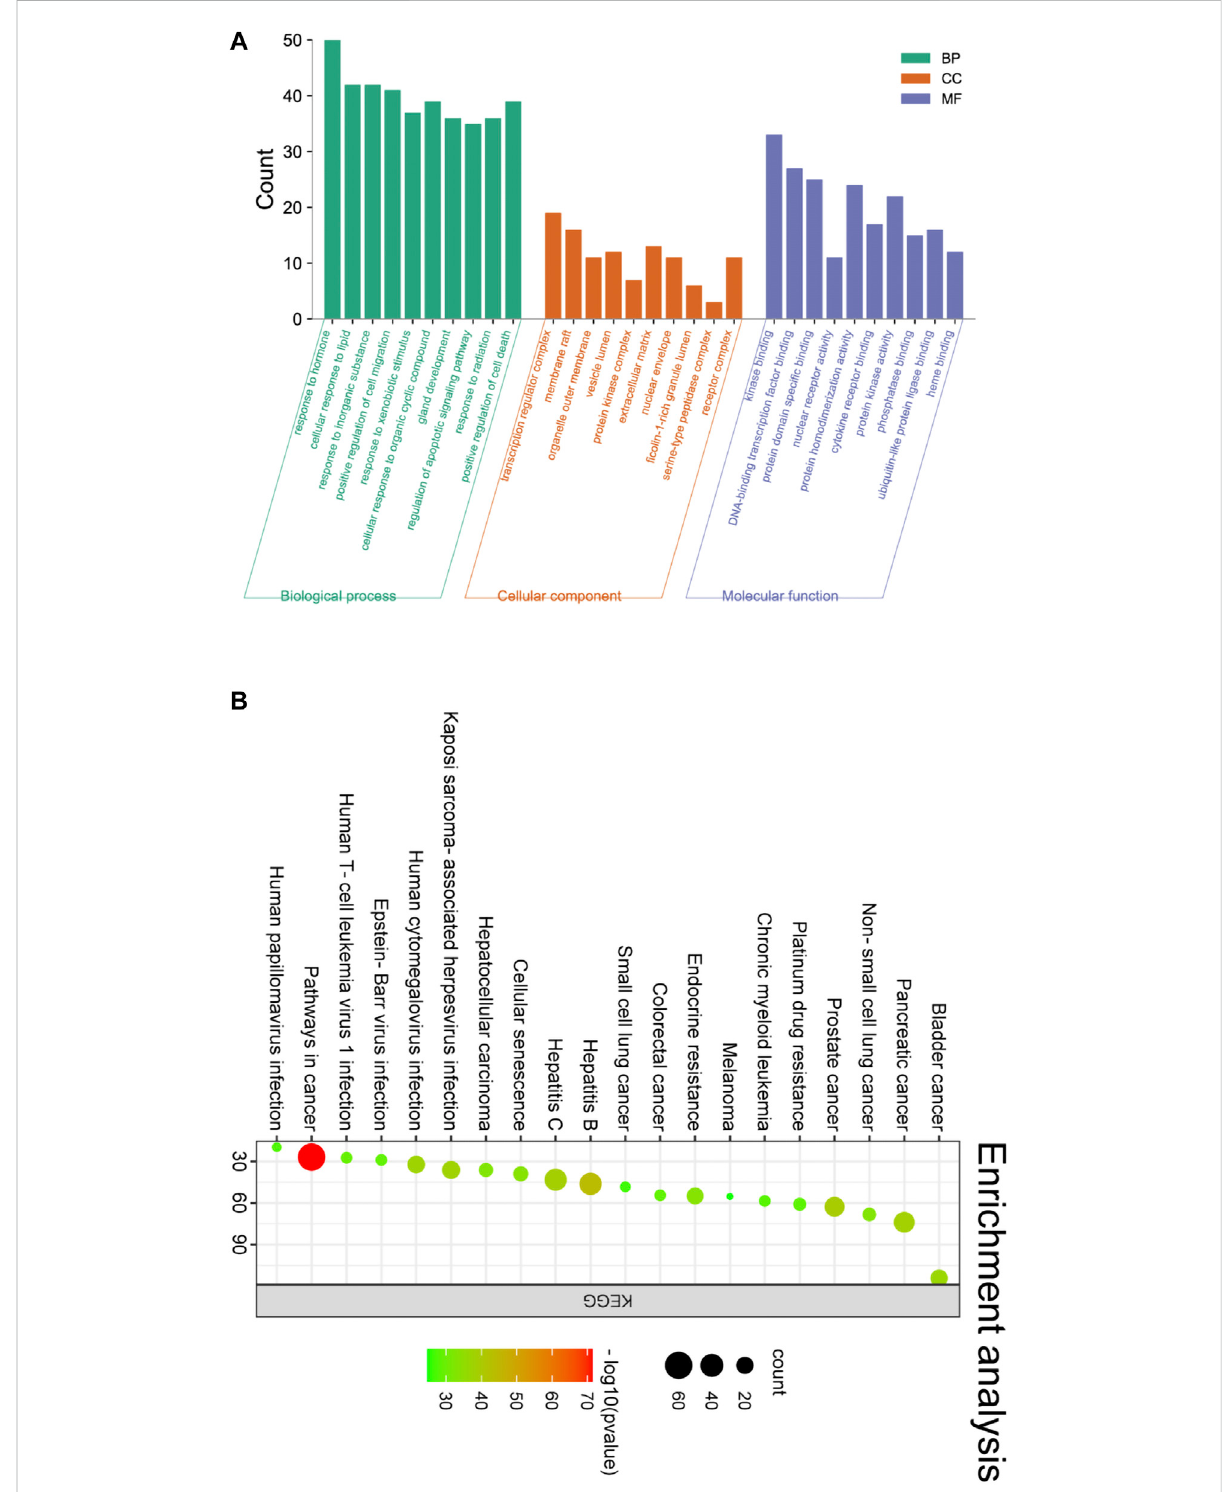
FIGURE 15 (A) GO functional enrichment analysis. (B) KEGG signaling pathway enrichment